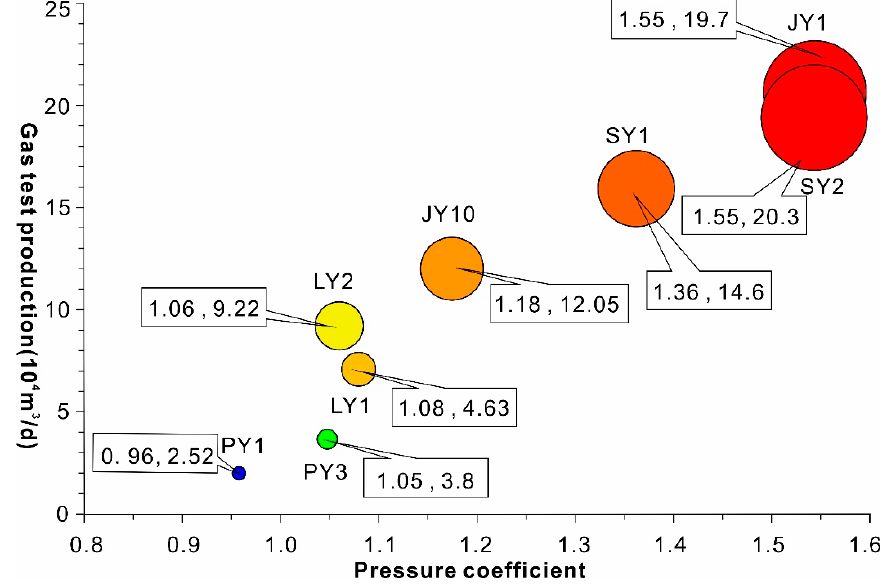
Figure 10. Relationship between formation pressure coefficient and gas